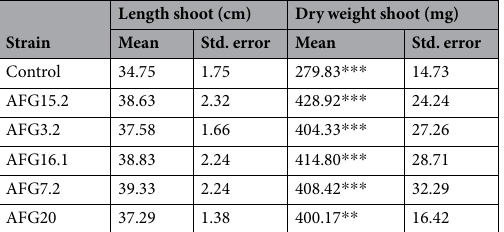
Table 2. Growth parameters of alfalfa plants inoculated with selected Arthrobacte r strains. Means and standard error (N = 12) are shown. Within columns, treatment means showing significant differences with control plants are marked with asterisks according to Tukey tests at P ≤ 0.1 ( * ), P ≤ 0.05 ( ** ) and P ≤ 0.01 ( *** ). Uninoculated alfalfa plants were used as